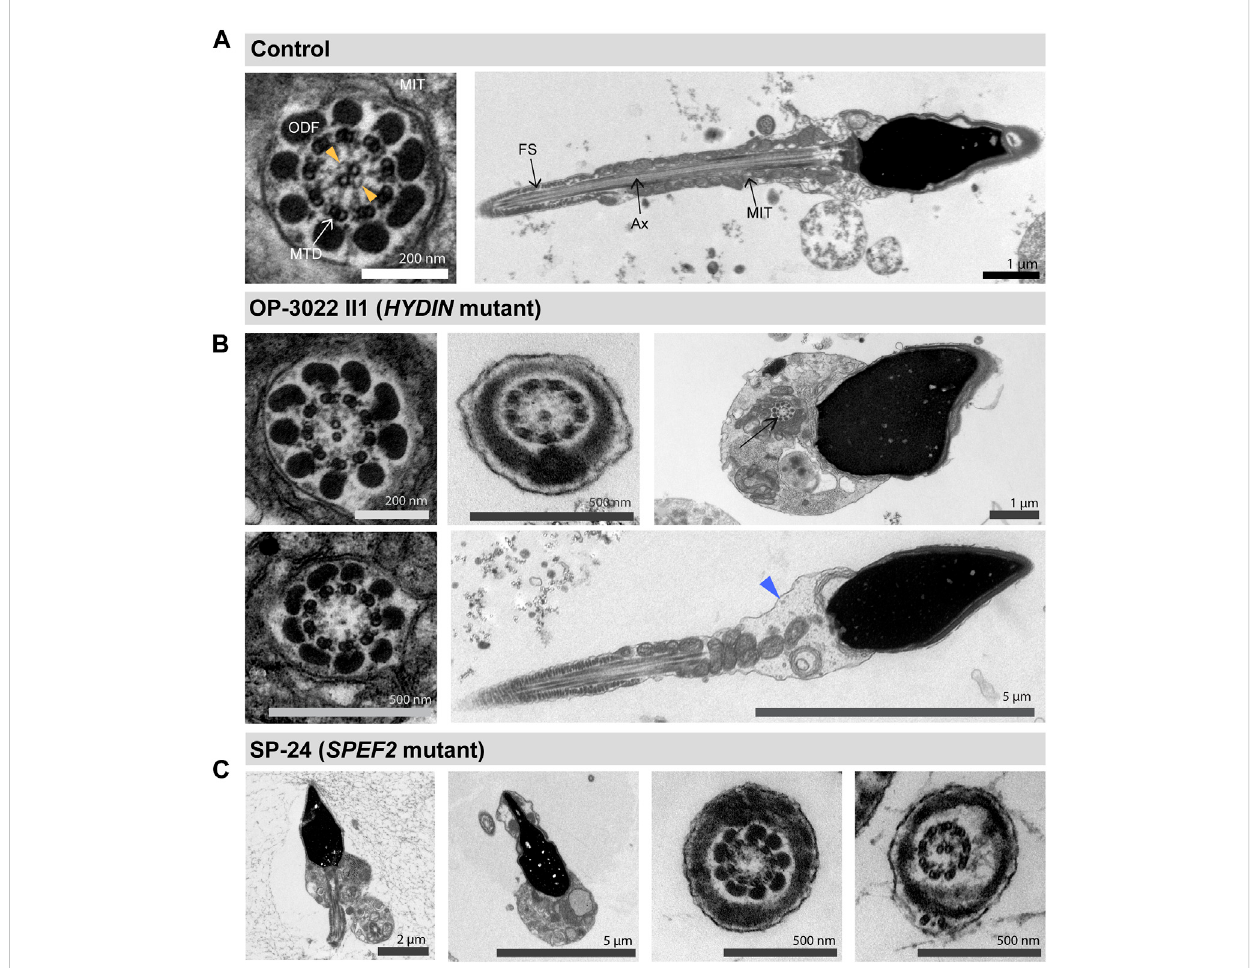
TEM analyses of HYDIN and SPEF2-de fi cient sperm displays morphological abnormalities. (A) TEM micrographs of sperm samples from a healthy control donor, showing a fl agellar cross section with a regular 9 + 2 axoneme of microtubule doublets (MTD), (left image), and a longitudinal section showing the axoneme (Ax) at the center, with regularly arranged mitochondria (MIT) and fi brous sheath (FS), respectively in the fl agellar mid piece and principal piece (right image). The orange arrowheads in the cross section indicate projections of the central pair associated apparatus. (B) HYDIN - mutant sperm display fl agellar cross sections with either a normal 9 + 2 ultrastructure of the axoneme displaying less pronounced CP projections (upper left image), or 9 + 1 cross sections with only one central microtubule (upper middle image), or a 9 + 0 axoneme without the CP (lower left image). Morphological abnormalities of the sperm fl agella are also observed, comprising sperm cells displaying a cytoplasmic bag with unassembled axonemal and peri-axonemal components (upper right image, arrow), or mid piece dysplasia (lower right image, indicate by a blue arrowhead). (C) SPEF2 -mutant sperm cells also display short and irregular fl agella ( fi rst left image), or a cytoplasmic bag with unassembled fl agellar components (second left image). Flagellar cross sections display either a 9 + 0 structure without the CP (second from the right image), or a 9 + 2 structure ( fi rst from the right